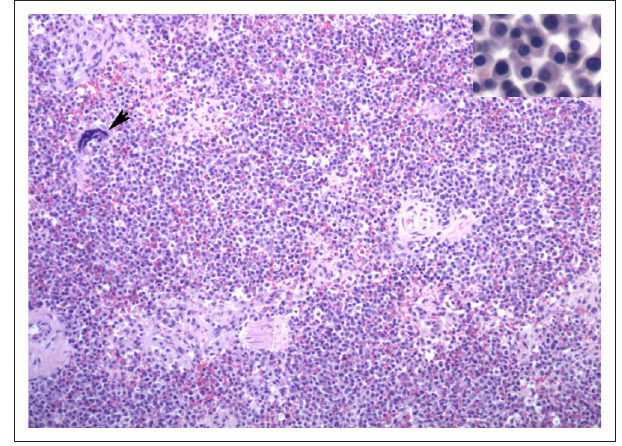
Arrow, a single giant myeloma cell. FIGURE 4: Haematoxylin and eosin (HE) staining of the lion spleen showing sheets of neoplastic round cells (see insert) expanding splenic sinusoids and a single giant myeloma cell.